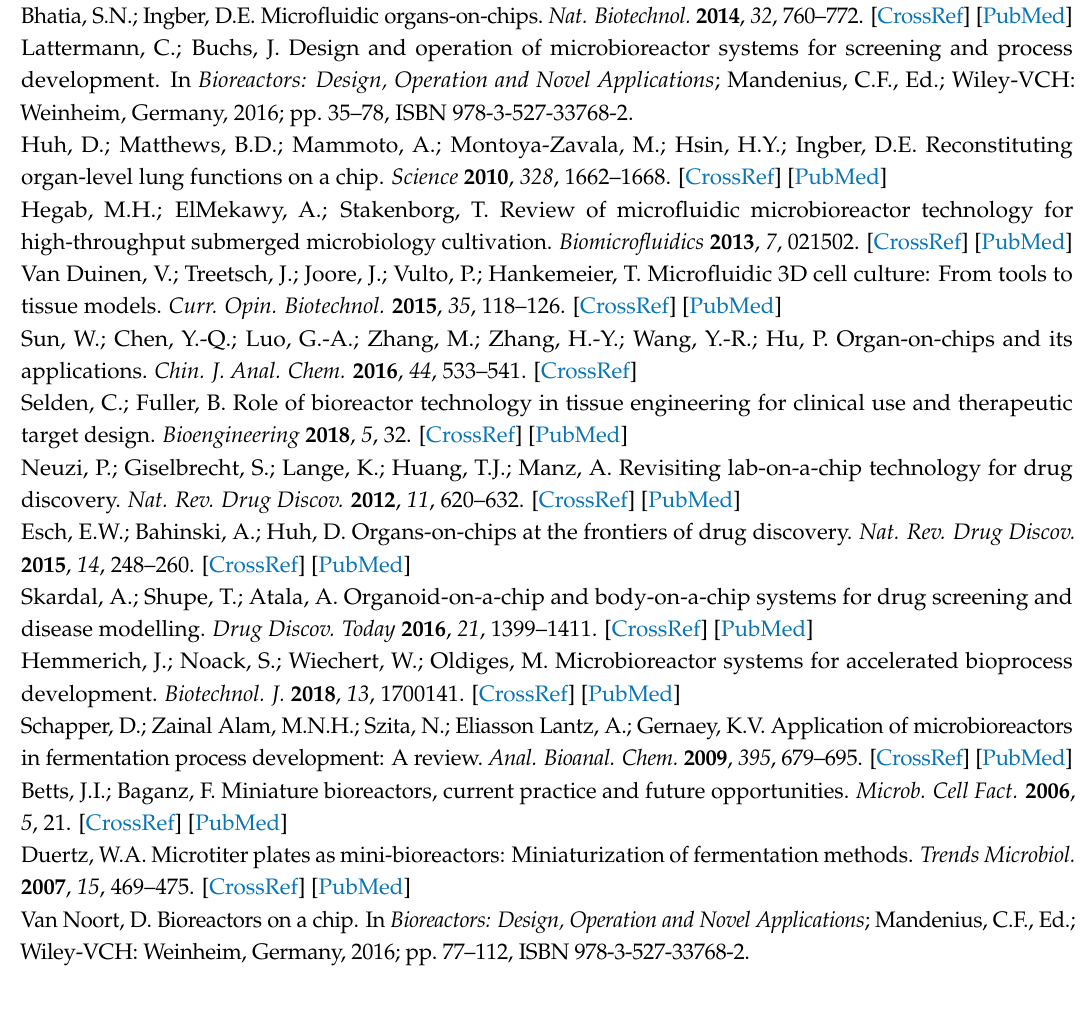
Table S1: Scoring of user needs versus real components for MBR for process development Configuration I, Table S2: Scoring of user needs versus real components for Heart-on-a-Chip Configuration